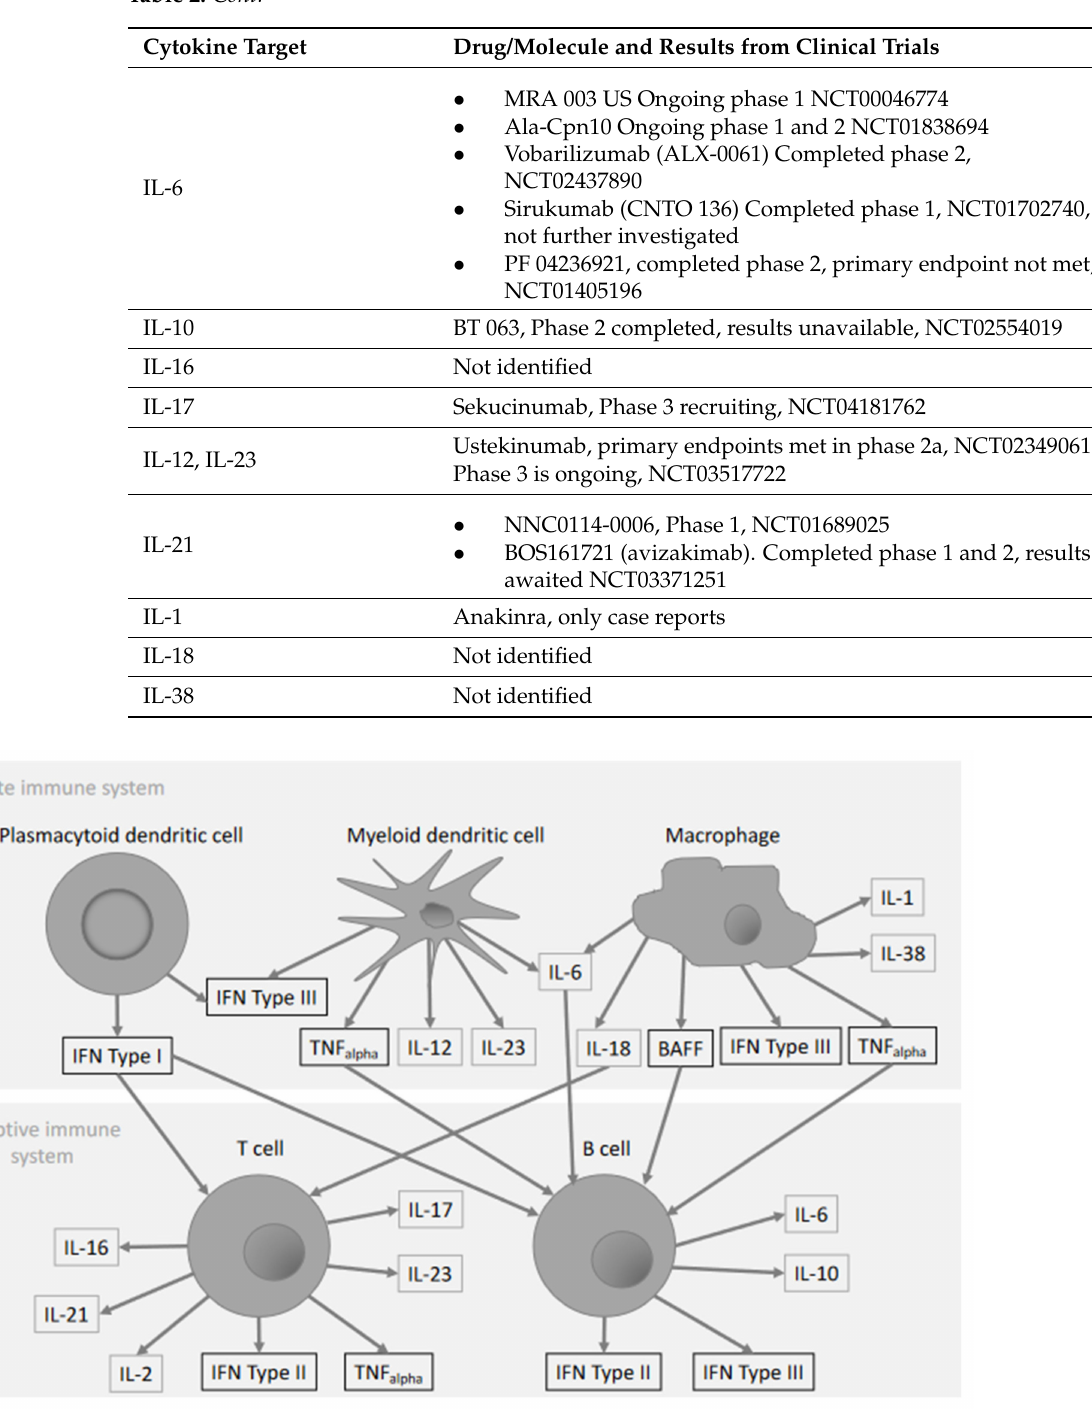
Figure 1. Cytokines associated with SLE pathogenesis are shown and arrows indicates the main producer or the main target